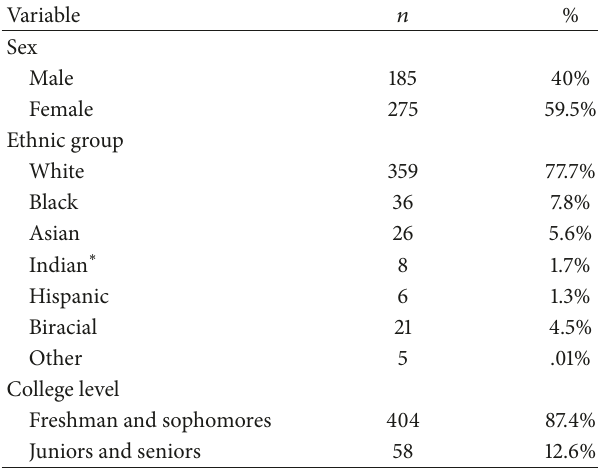
Table 1: Demographic information and student responses for sun protection